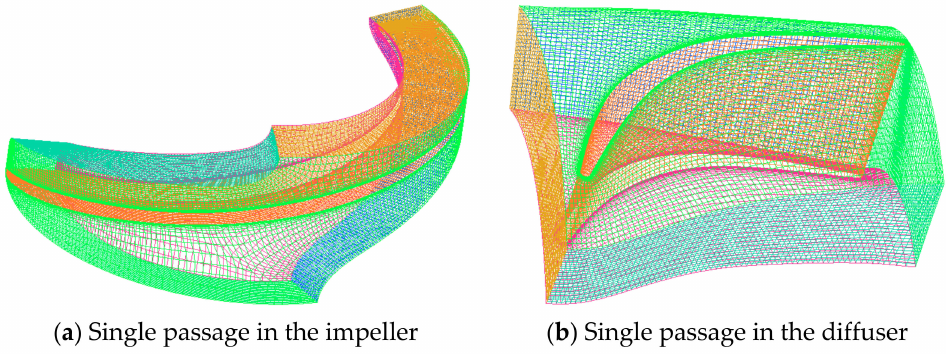
Figure 3. Schematic diagram of structured mesh.